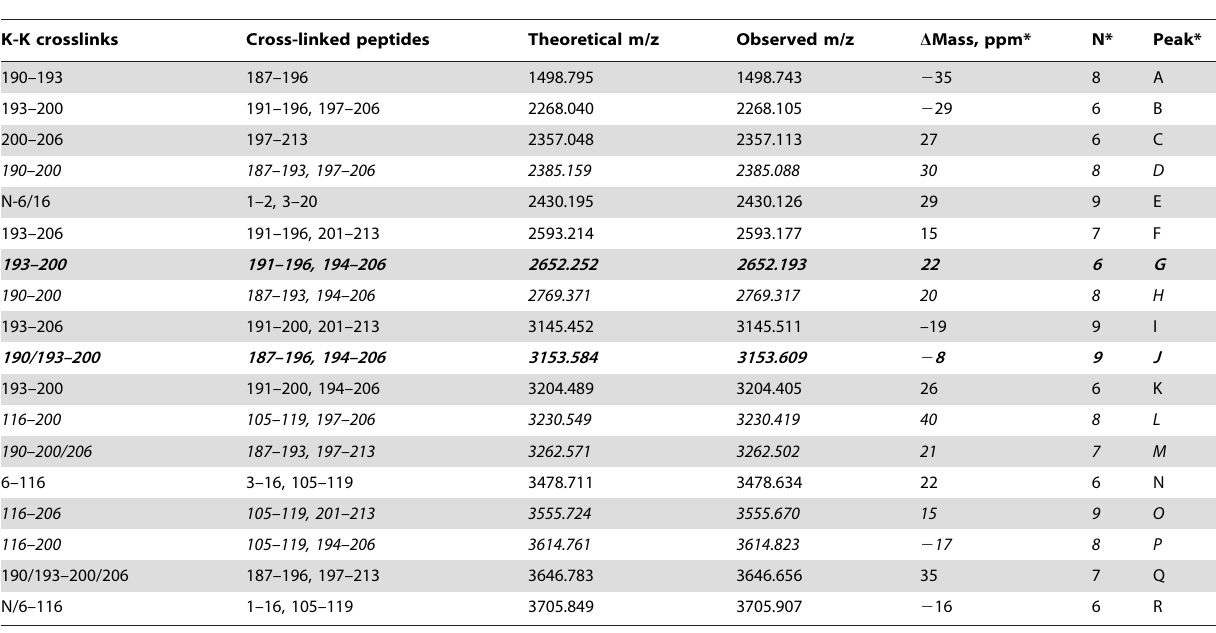
Table 2. Intra-/Intermolecular crosslinks identified by mass spectrometric studies of higher order oligomeric GlyBP bands.